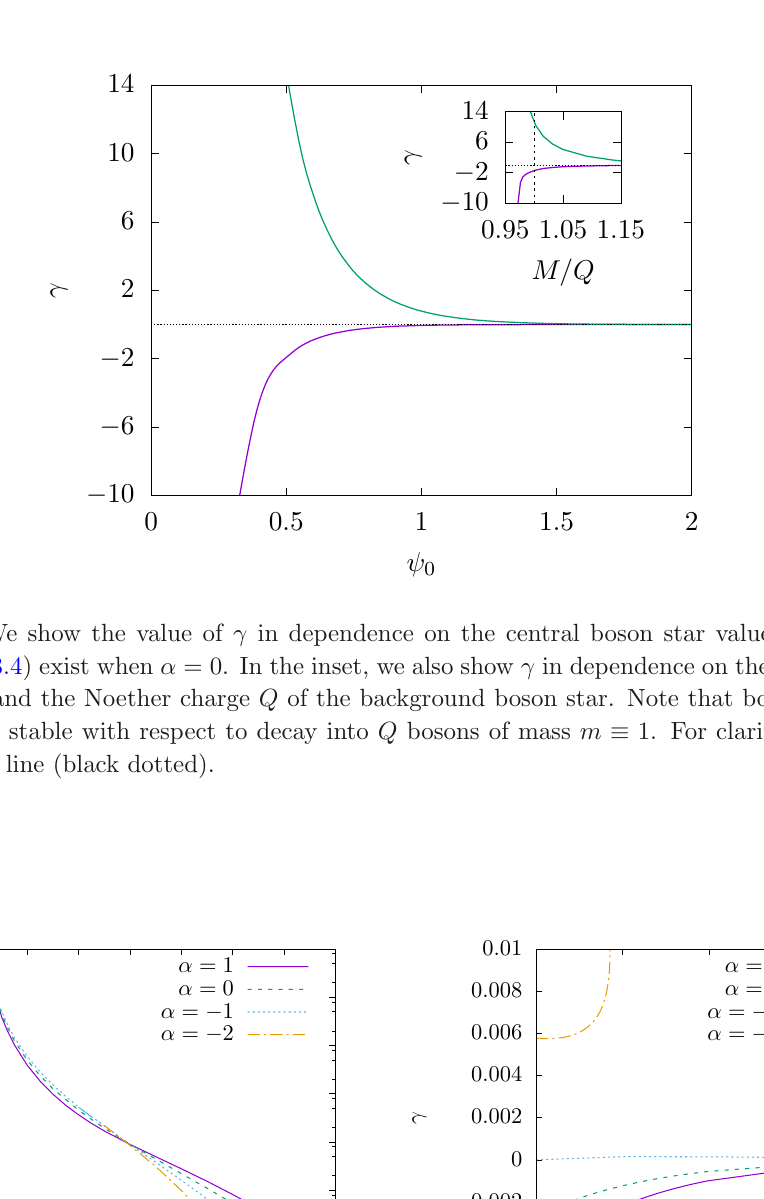
Figure 5 . We show the dependence of the value of the parameter γ < 0 for which non-trivial solutions of (3.4) exist, on the central value of the complex scalar field forming the boson star, ψ 0 , for different values of α . The left figure shows the interval ψ 0 [0 : 1 . 4] , while the right figure ∈ shows the interval ψ 0 [1 . 4 : 1 . ∈